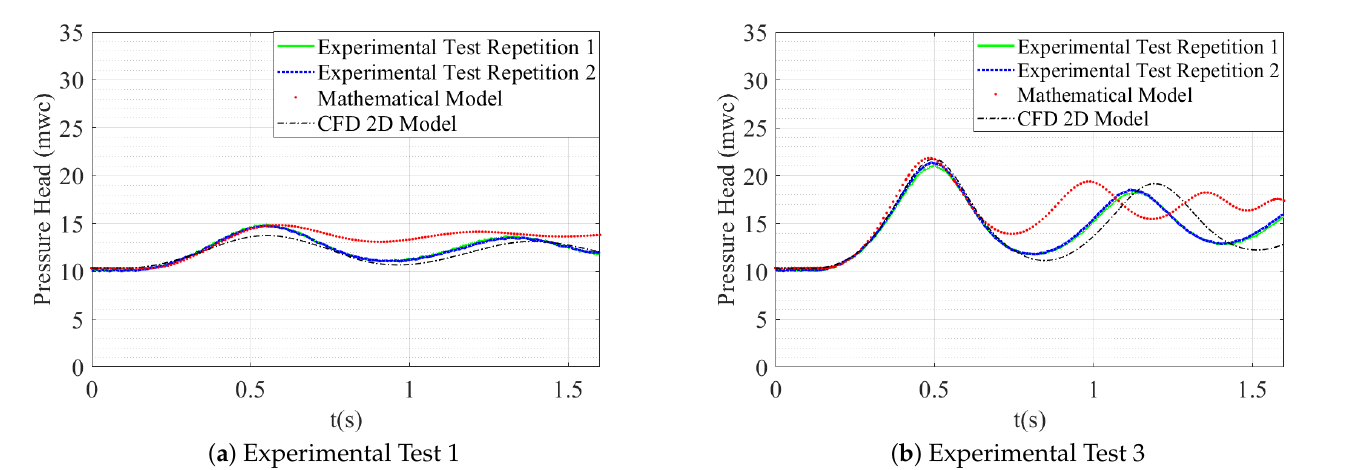
Figure 5. Behaviour of p in the air pocket during the filling process throughout its complete release.